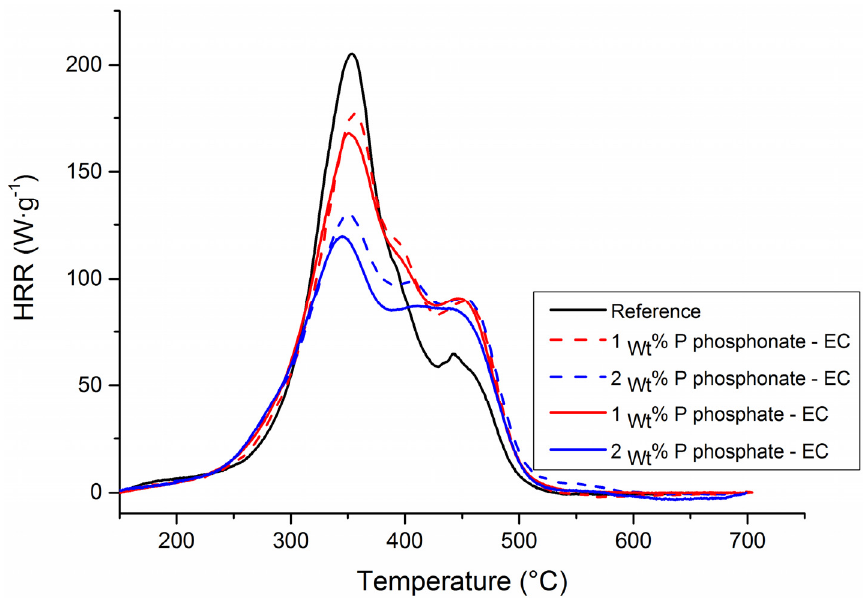
Figure 5. PCFC curves of reference EC alkyd resin and PO x CR diluent EC alkyd resins. Table 4. Results of PCFC analyses of reference EC alkyd resin and PO x CR diluent EC alkyd resins .